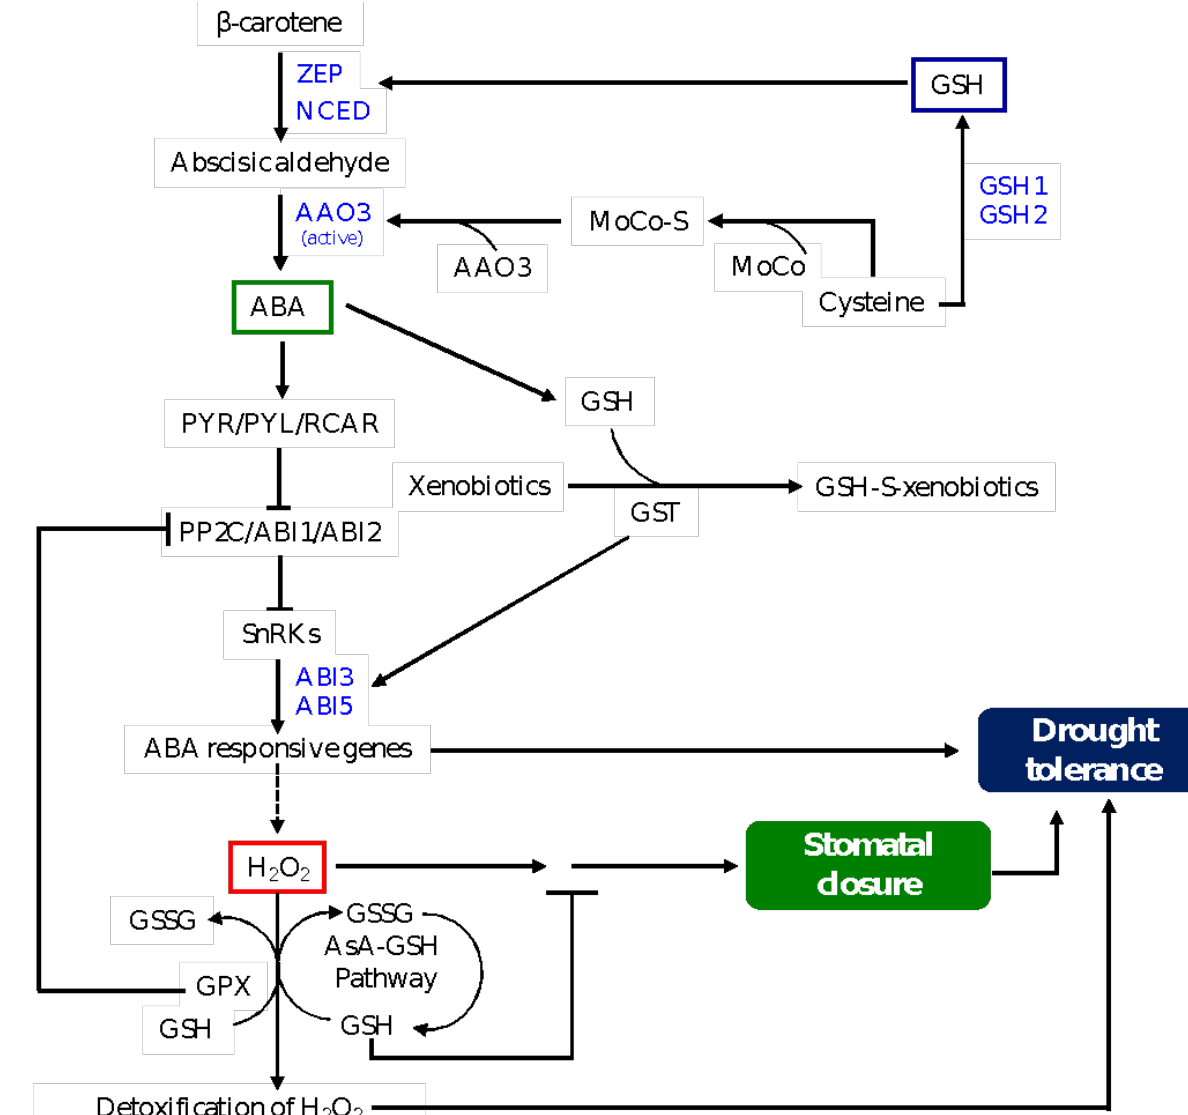
Figure 3. A model depicting GSH-mediated ABA signaling in stomatal closure and drought tolerance. Induction of GSH biosynthesis reduces the level of cysteine, which plays a role in activating the AAO3 enzyme and therefore ABA synthesis in the guard cells, leading to inhibition of ABA-induced stomatal closure. Whereas drought-induced GSH level enhances the expression levels of ZEP and NCED , resulting in an increase in ABA synthesis, GST detoxifies xenobiotic substances by conjugating them with GSH, leading to induction in the expression of genes encoding ABI3 and ABI5, transcription factors that directly activate the expression of ABA responsive genes and drought tolerance. GSH is involved in the regulation of the downstream signaling of ABA-induced H 2 O 2 in the guard cells and thereby preventing stomatal closure. GSH is also involved in the detoxification of H 2 O 2 through the AsA-GSH pathway. The role of GPX is as described in Figure 2, and it promotes ABA-induced stomatal closure and drought tolerance via inhibiting ABI2, which acts as a negative regulator of ABA signaling. ABA signaling components are described in Figure 2. ZEP, zeaxanthin epoxidase; NCED, 9- cis -epoxycarotenoid dioxygenase; AAO3 abscisic aldehyde oxidase3; MoCo, molybdenum cofactor; MoCo-S, sulfurylated MoCo; AsA, ascorbate.